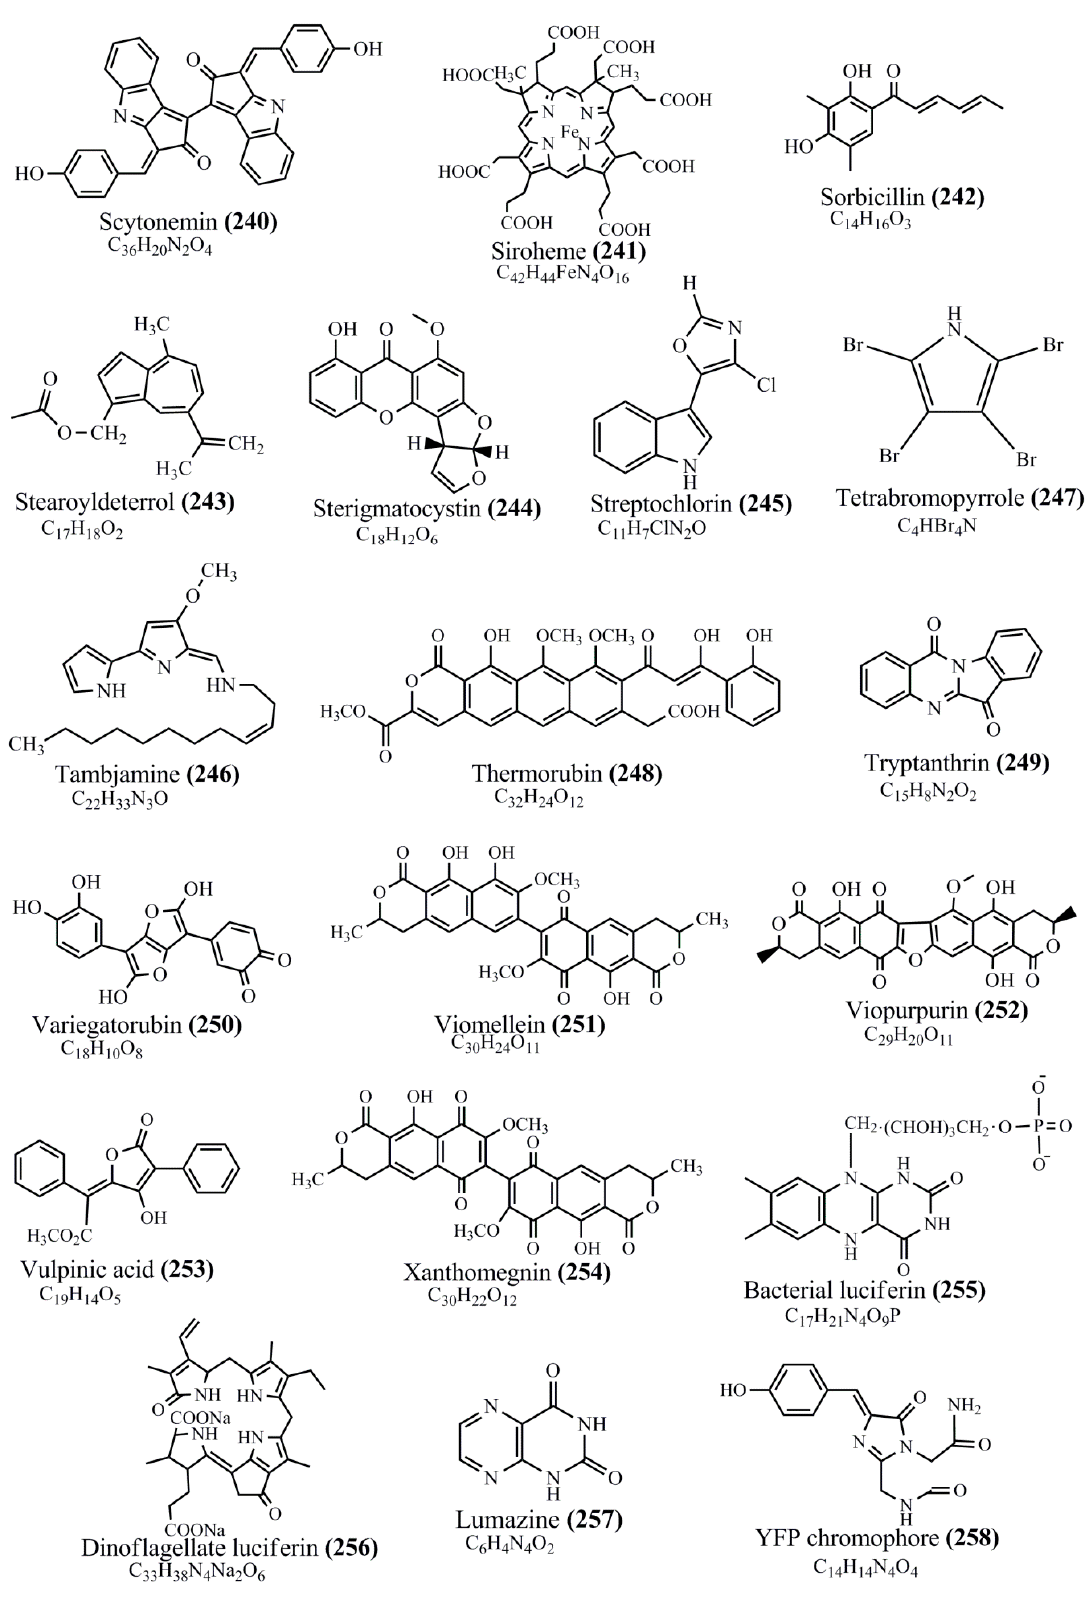
Figure 1. Continued. Figure 1.